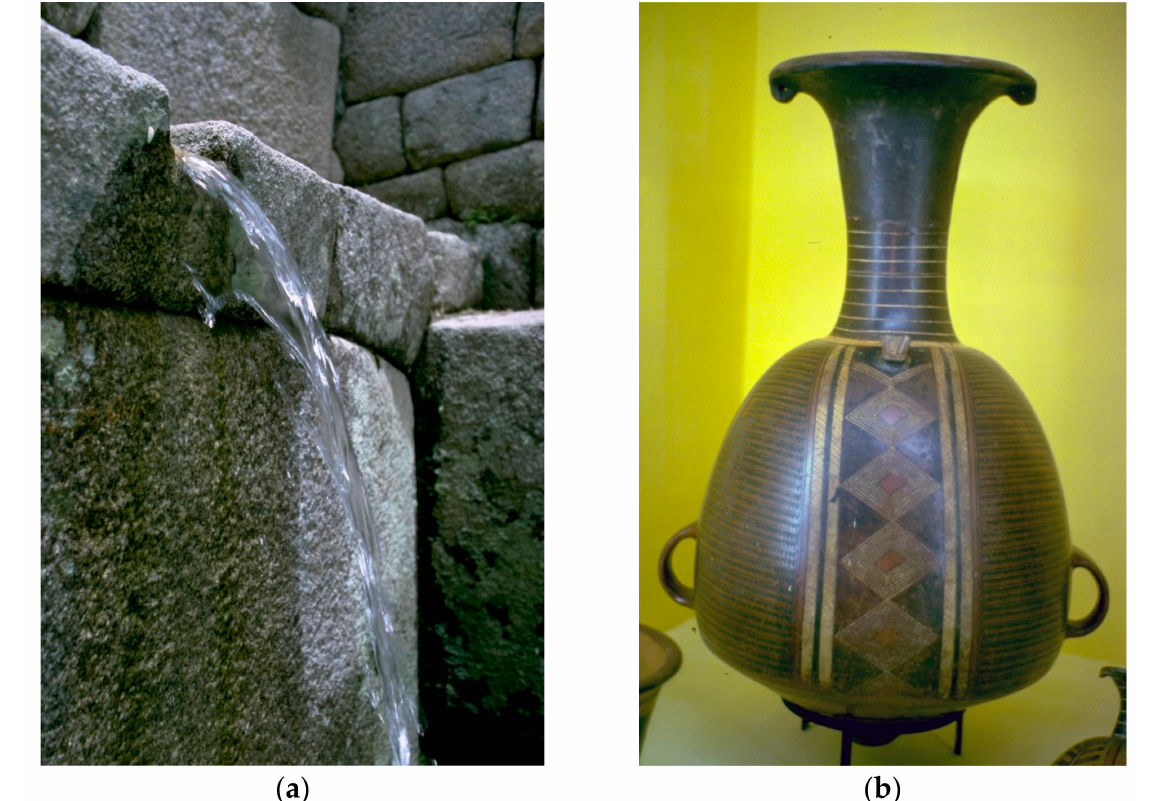
Figure 9. Inca engineers designed water jets that were sized perfectly for the range of flows ( a ) and which allowed for clay Inca water jugs known as aryballos ( b ) to easily be